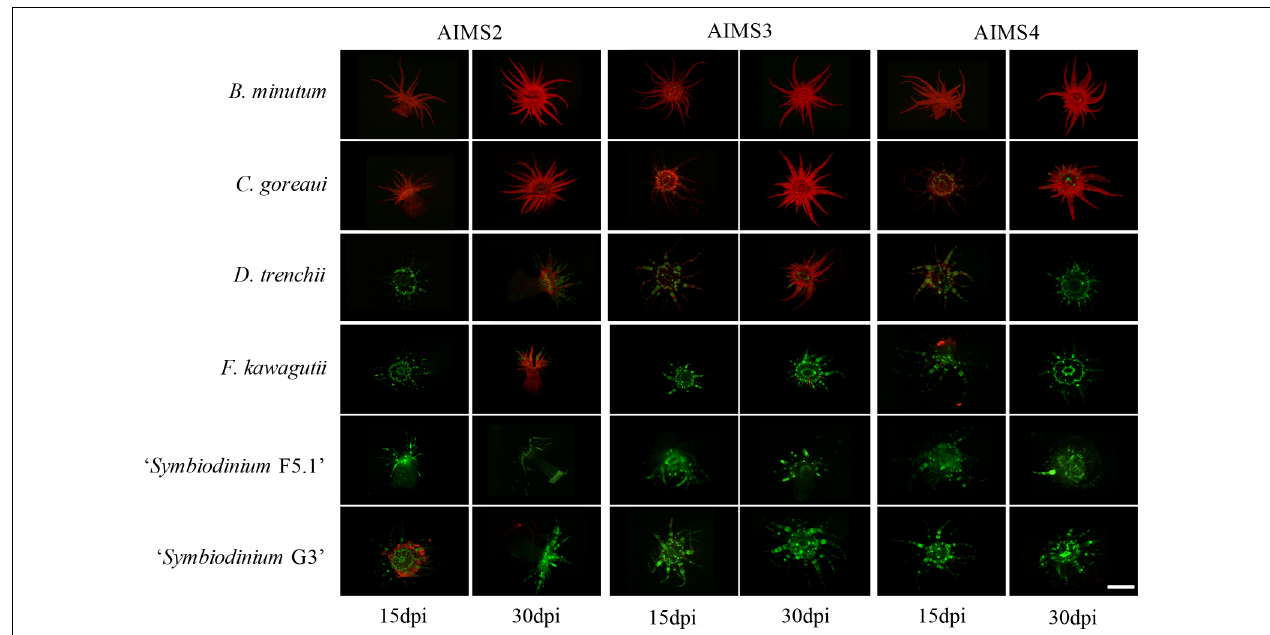
FIGURE 2 | Representative fluorescence microscopy of the three E. diaphana genotypes (AIMS2, AIMS3, AIMS4) colonized by six Symbiodiniaceae strains ( B. minutum , C. goreaui , D. trenchii , F. kawagutii , “ Symbiodinium F5.1 ,” and “ Symbiodinium G3 ”) at 15 and 30 dpi. Symbiodiniaceae chlorophyll autofluorescence is in red, and E. diaphana autofluorescence is in green. Pictures of anemones inoculated with S. tridacnidorum are not shown as exposure to this strain resulted in the death of all host organisms. Scale bar 3